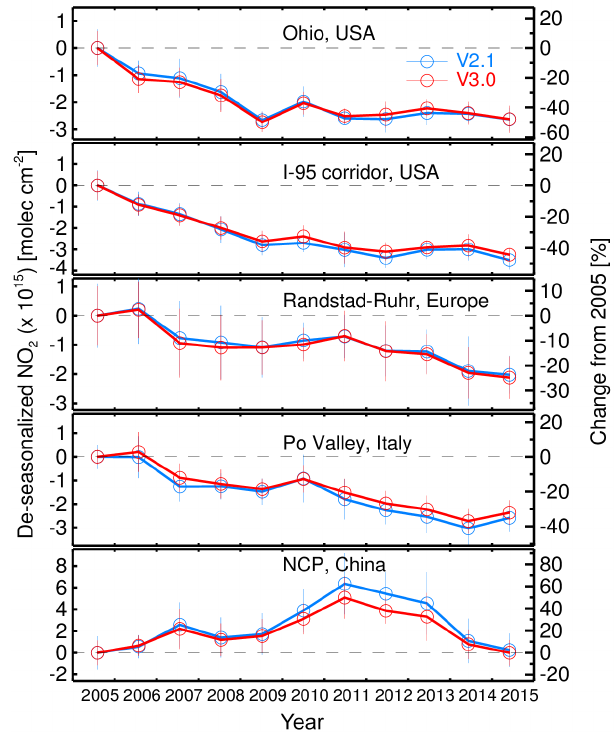
Figure 6. Annual average OMI NO 2 V trop regional trends for se- lected regions outlined in Figs. 5 and 7–8. The regions in the eastern US and eastern China have been presented in Krotkov et al.